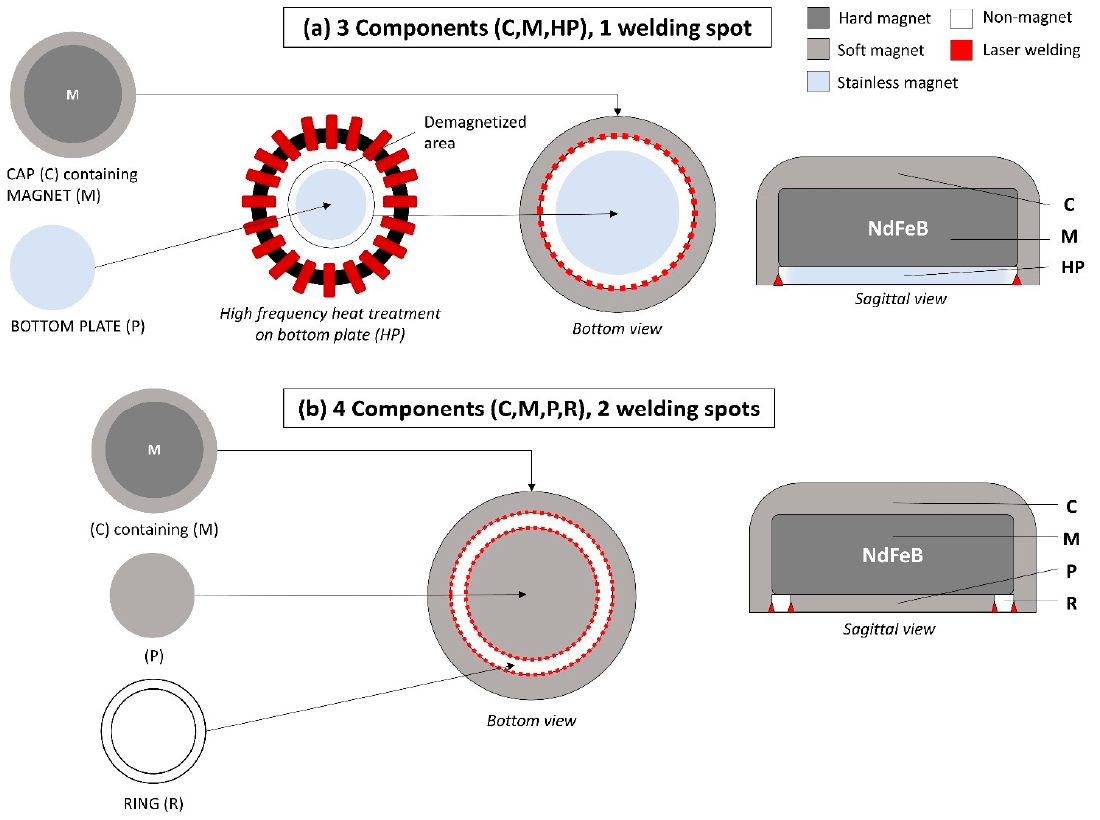
Figure 2. Structural differences between the novel magnetic attachment ( a ) and the conventional magnetic attachment ( b ).